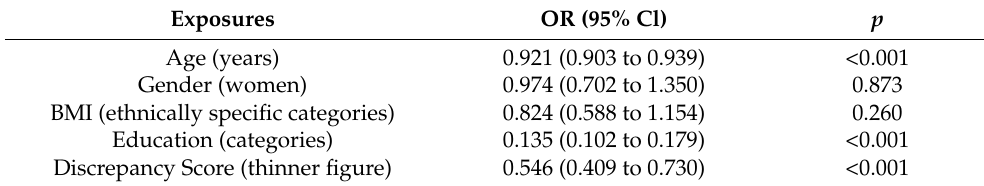
Table 2. Differences between Chinese migrants and native Italians at multivariate logistic regression (adjusted for all exposures reported in the